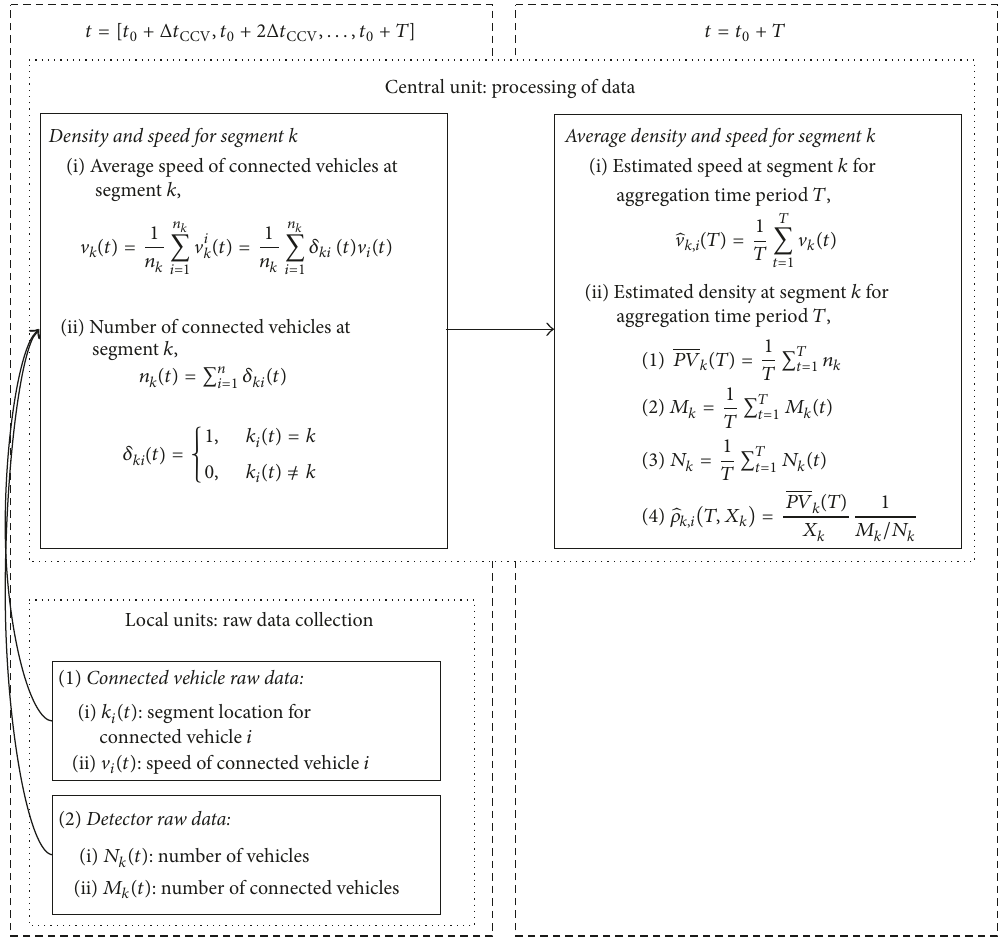
Figure 1: The communication flow between the local units (connected vehicles and detectors) and the central unit for the aggregation time period 𝑇